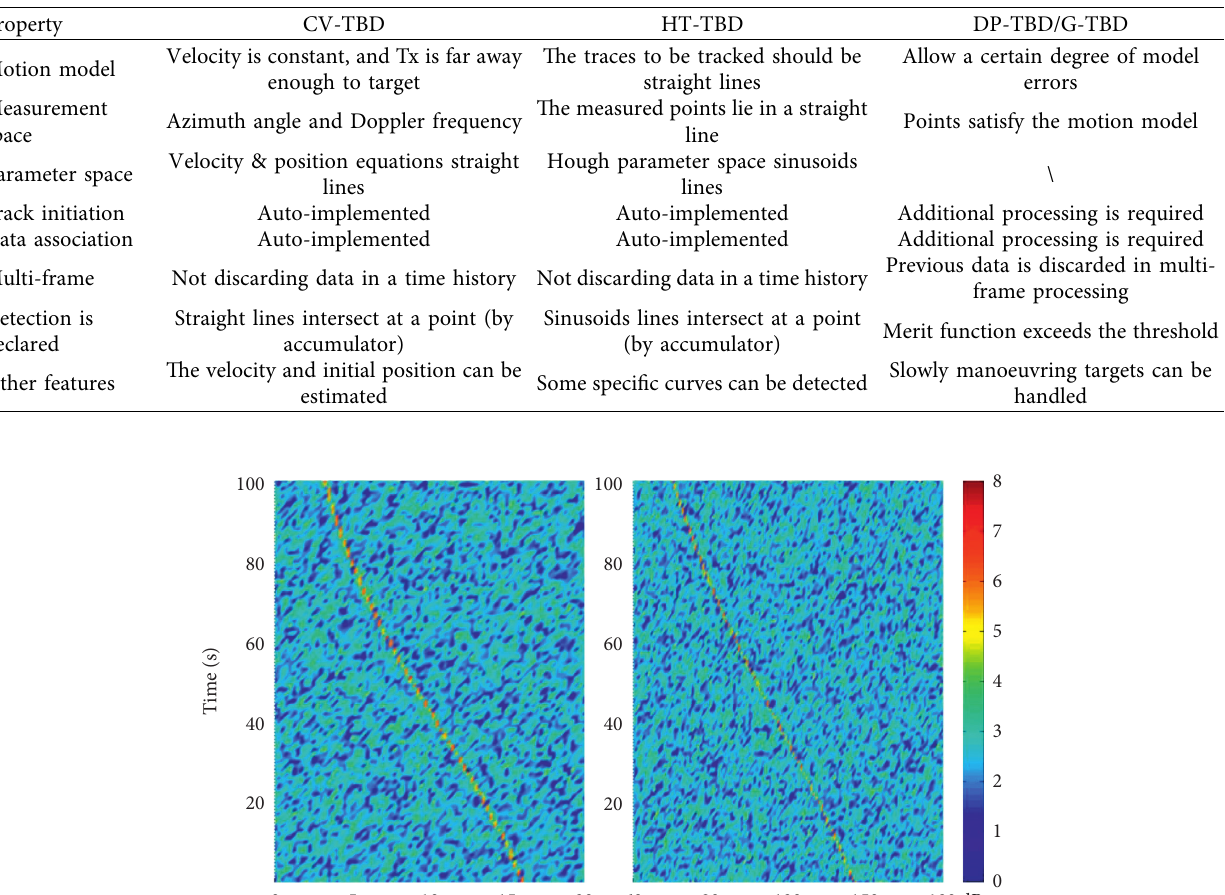
Table 1: Property comparison of the CV-TBD, HT-TBD, and DP-TBD/G-TBD.